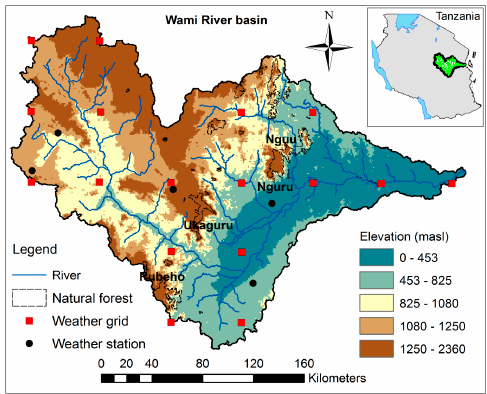
Figure 1. The Wami River basin (elevation, rainfall stations and grid points from Shuttle Radar Topography Mission (SRTM), Tanzania Meteorological Agency (TMA) and Inter-Sectoral Impact Model Intercomparison Project (ISI-MIP) databases, respectively).